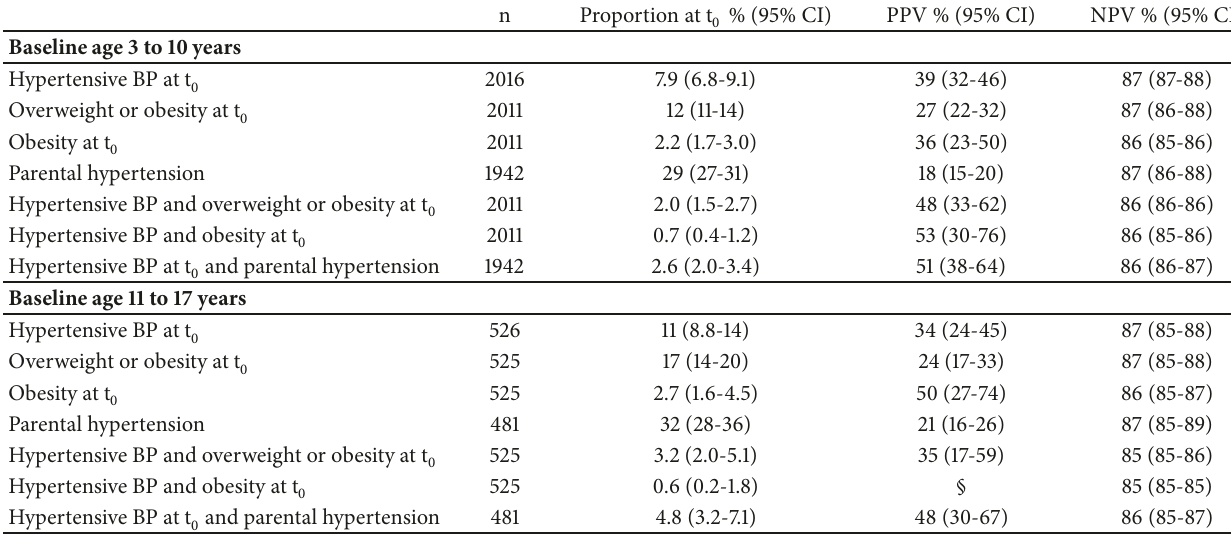
Table 4: Positive (PPV) and negative predictive value (NPV)of various hypertension risk factorsor risk factor combinations for hypertensive BP ∗ at six-year